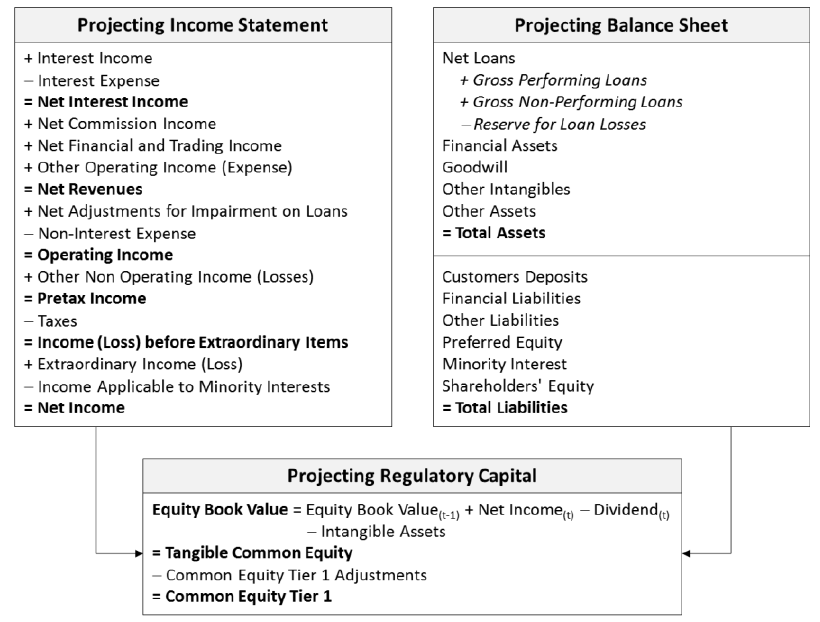
Figure 1. Projecting Income Statement, Balance Sheet and Regulatory Capital.